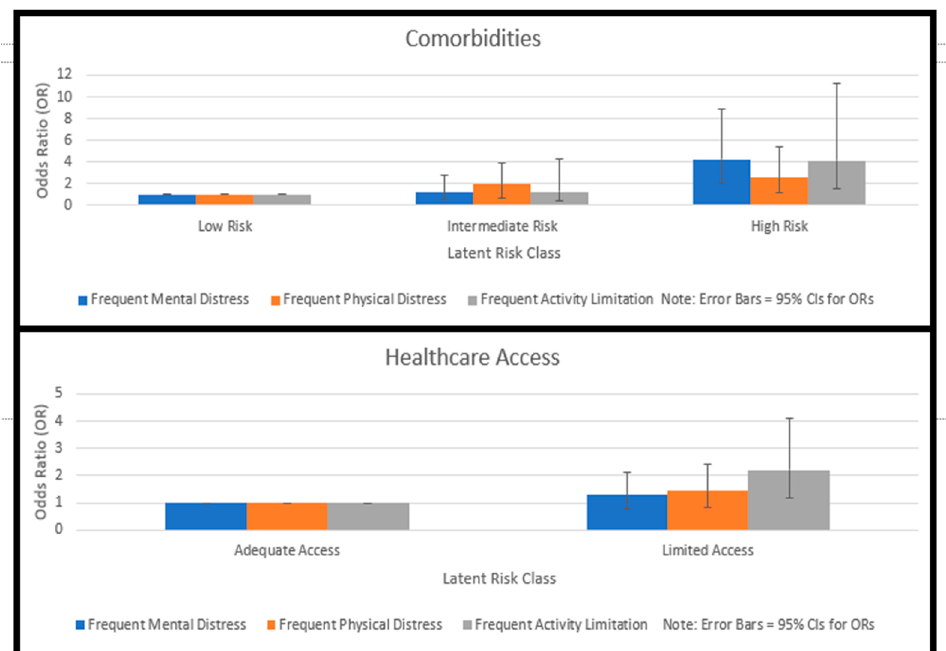
Figure 5. Google Map visualization depicting percentage of employed KY adults with COPD who reported comorbidities. Kentucky is selected on the Google Map. The percentage of BRFSS respondents with comorbid health conditions and health care access variables are displayed on the left side. Bar charts can be selected by clicking the upper right-hand corner to open pairwise state comparisons describing the percentage of KY respondents reporting each comorbidity as compared to respondents in each of the other three U.S. states (NC, TN, and WV).